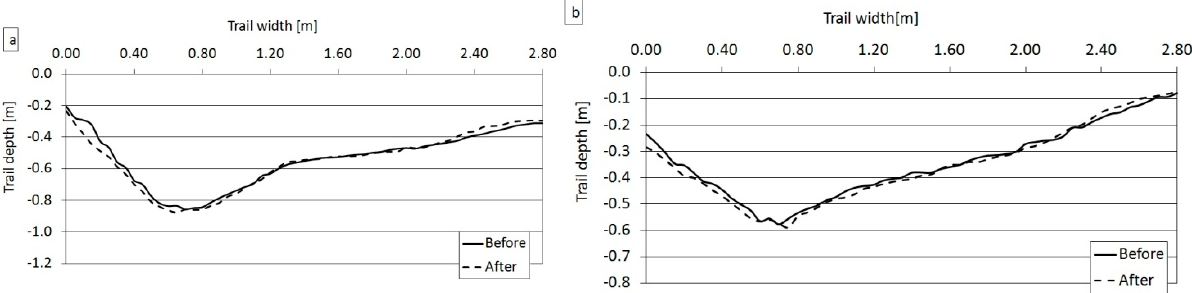
Figure 7. Topography on the trail sections before and after skidding: ( a ) Ht130U and ( b ) Ht130L.